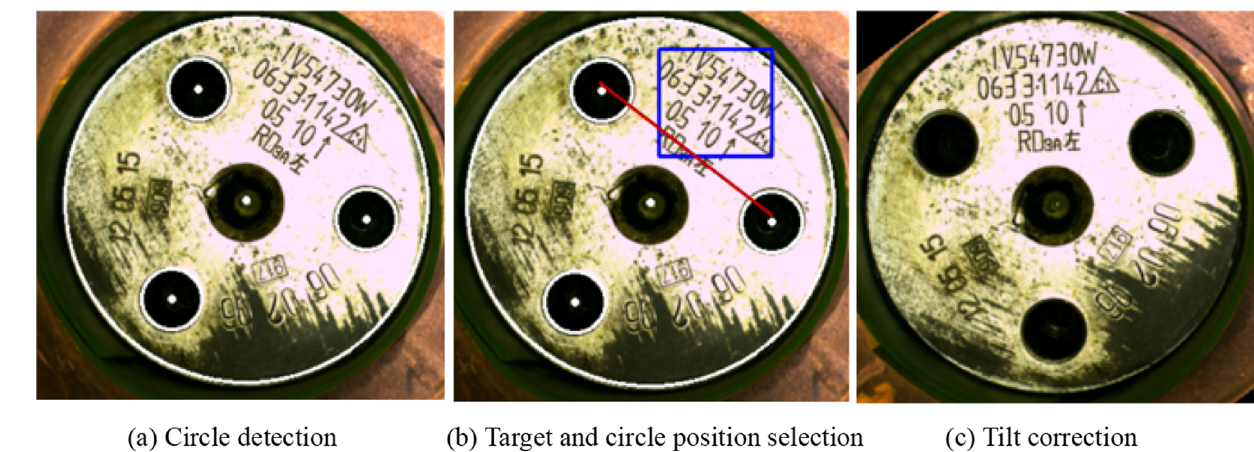
Fig. 11 Tilt correction effect with an angle between plus and minus 90°